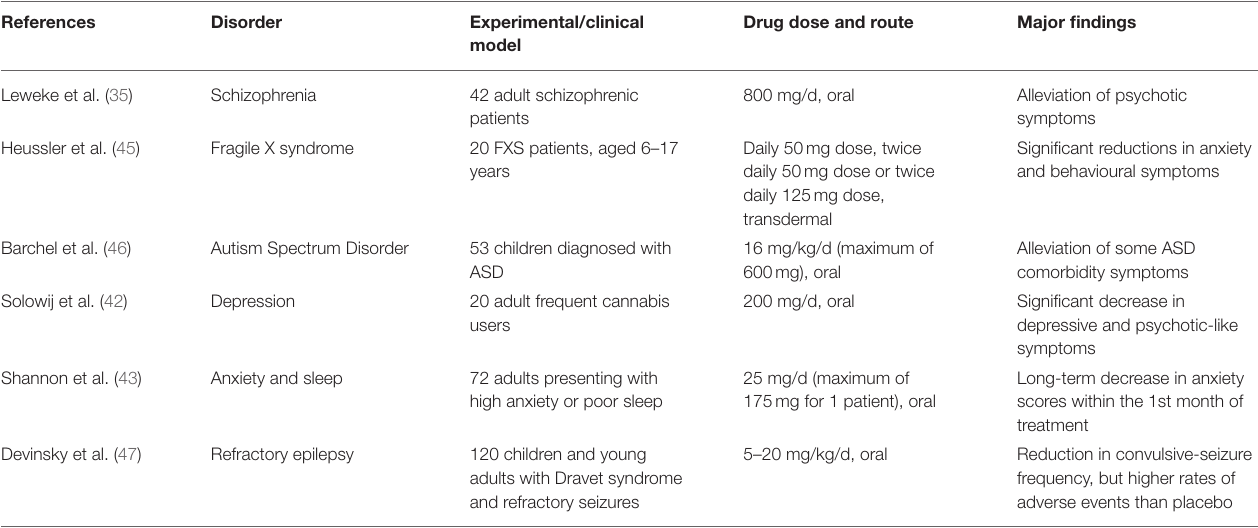
TABLE 1 | Summarised findings of some referenced experiments/clinical trials in humans, which demonstrate the wide range of neurological disorders that CBD therapy could potentially be effective